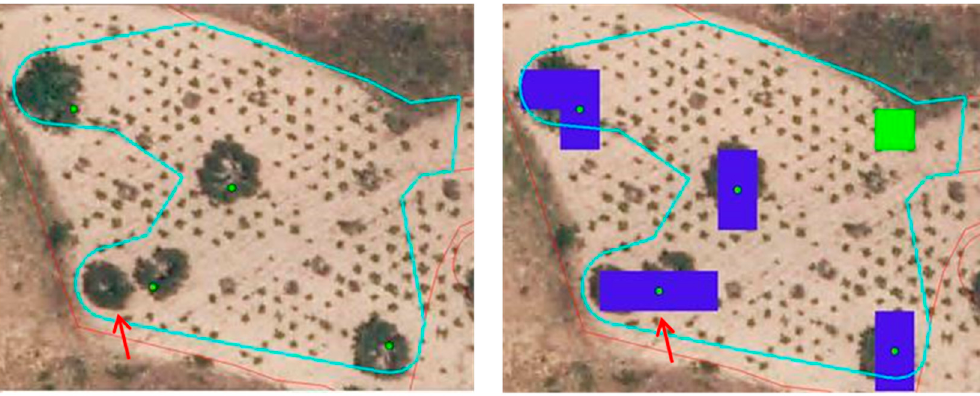
Figure 10. Errors of omission in the classification of isolated trees.